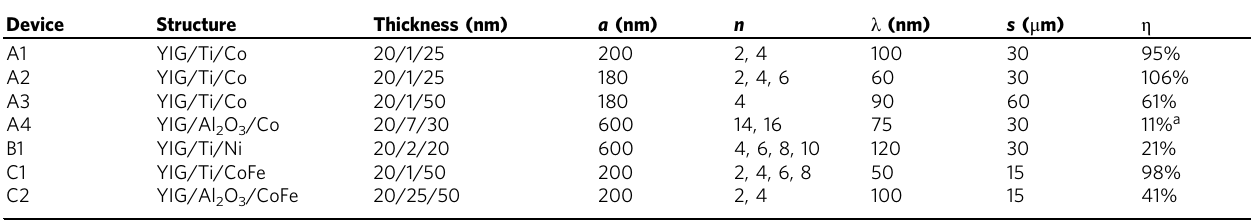
Table 1 Parameters and properties of seven devices